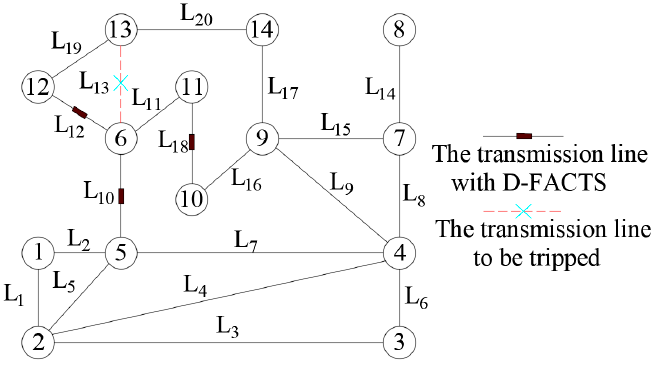
Figure 2. IEEE 14-bus power system. Table 1. All alternate paths and full transmission lines of an alternate path when the tripped line is L 13 in the IEEE 14-bus power system.